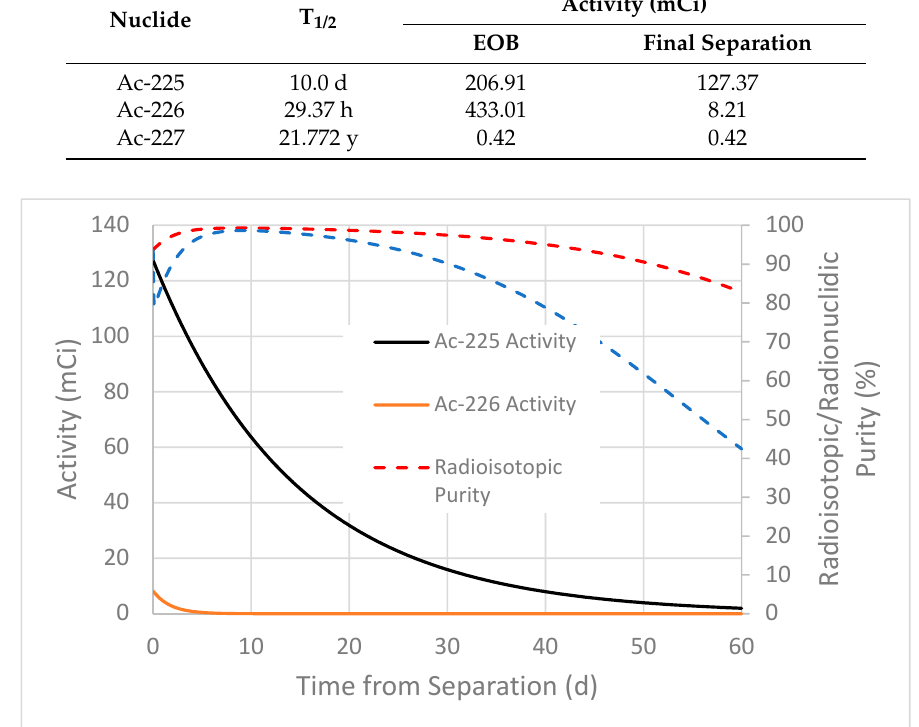
Table 2. Radioactive quantities of actinium isotopes produced in a proton irradiated thorium target produced at the Brookhaven Linac Isotope Producer (BLIP). Parameters for calculations: a 1 g Thorium-232 target (450 mg cm − 2 ); proton irradiation at 192 MeV; 150 µ A for ten days. Final separation is seven days post End of Bombardment (EOB).